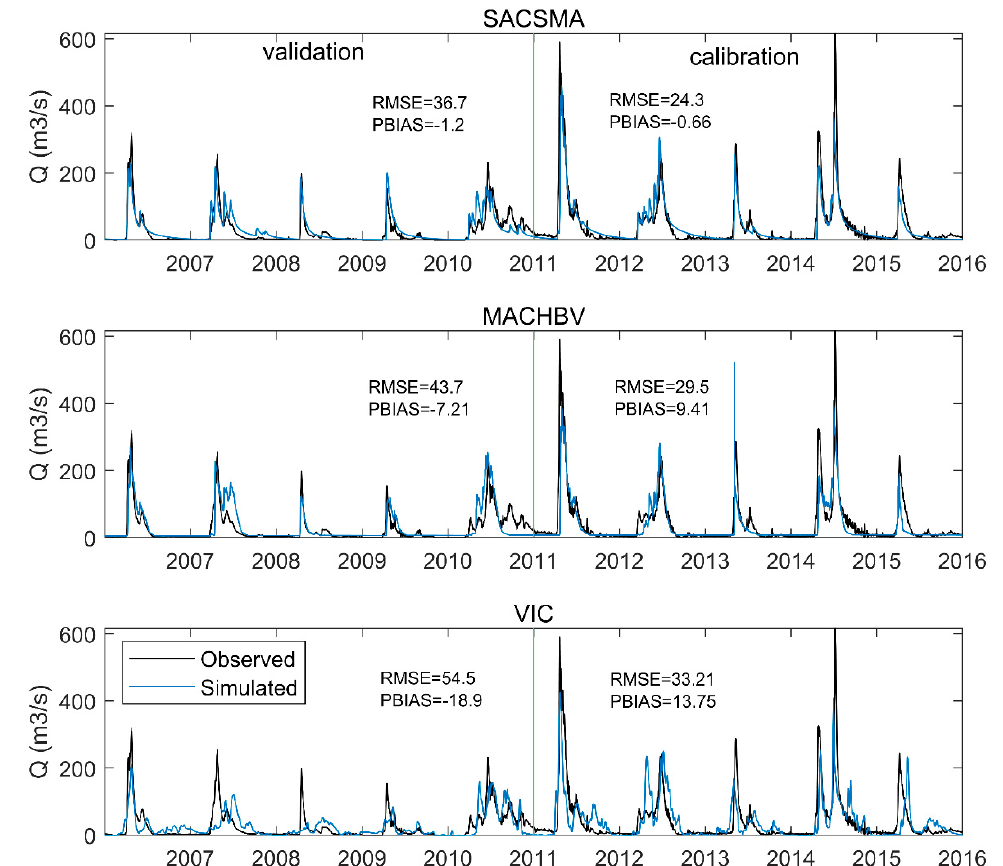
Figure 5. Calibration and validation plots of SACSMA with SNOW17, MACHBV with SNOW17, and Variable Infiltration Capacity (VIC) with routing module (RVIC) models. RMSE: Root-Mean-Square Error, and PBIAS: Percent Bias [81] are displayed for each model to provide more information in addition to the visual inspection of the time series. Table 1. Performance statistics of the three hydrological models from calibration and validation. The definition of the abbreviations is presented in Section 3.2.